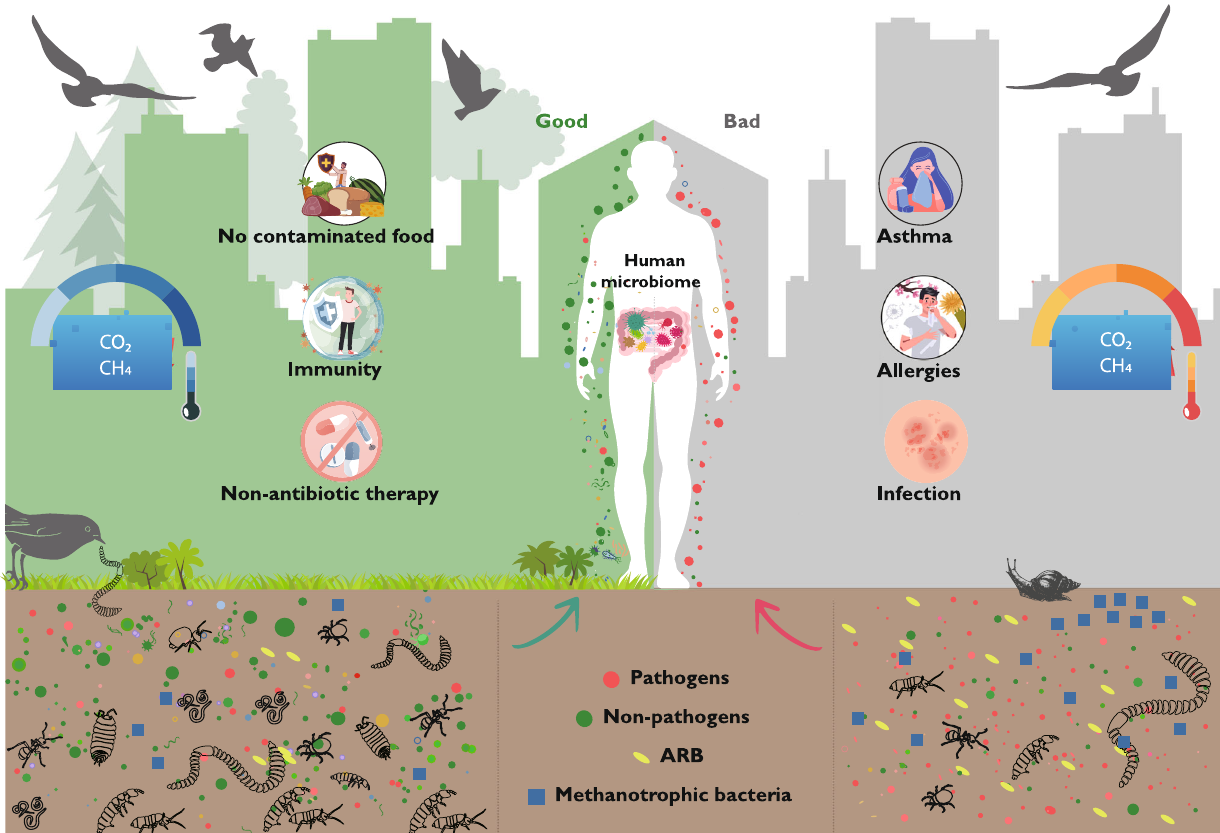
Fig. 2 Harnessing soil biodiversity for advancing human health in cities. Conserving biodiverse green spaces and establishing more green infrastructure bene fi t the maintance of soil health by increasing soil biodiversity, supressing soil pathogens and antibiotic resistance bacteria (ARB), and reducing the amount of the microorganisms that increase rates of methane and nitrous oxide emissions. Appropriate management of soil biodiversity in cities can reduce the risk of immune-mediated diseases and improve human health in cities via reducing pathogens, purifying soil pollutants, as well as enhancing the human immunoregulation, and modulating the human